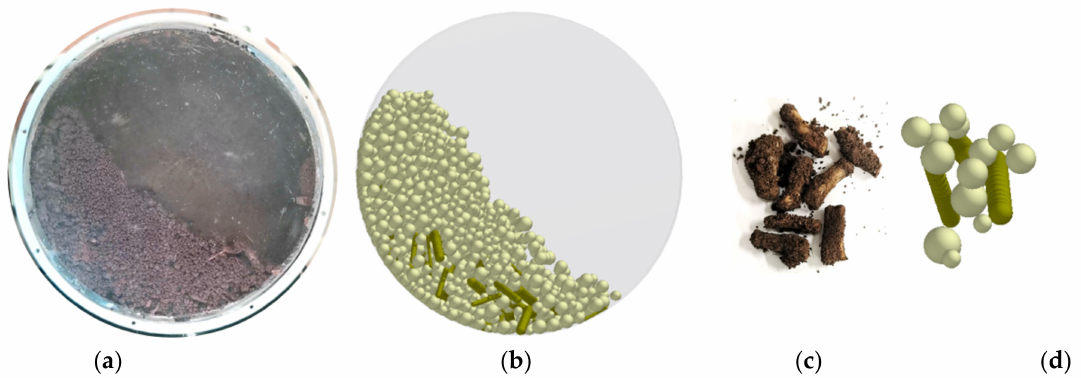
Figure 17. Accumulation layer of MSRM and Soil-Root aggregation in measured ( a , c ) and simulated ( b , d ) drum